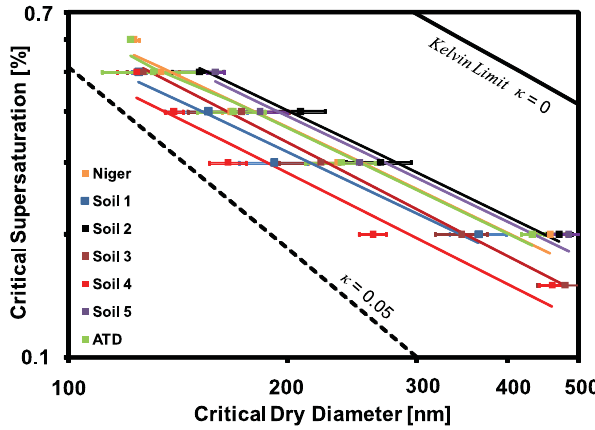
Fig. 5. CCN activation curves for different dust types presented in Table 1. Symbols show experimentally determined CCN activity and lines show FHH adsorption activation fits. Error bars represent measurement uncertainty in D dry . Also shown in black thick line is the κ = 0, Kelvin curve. Black dashed line corresponds to κ = 0 .